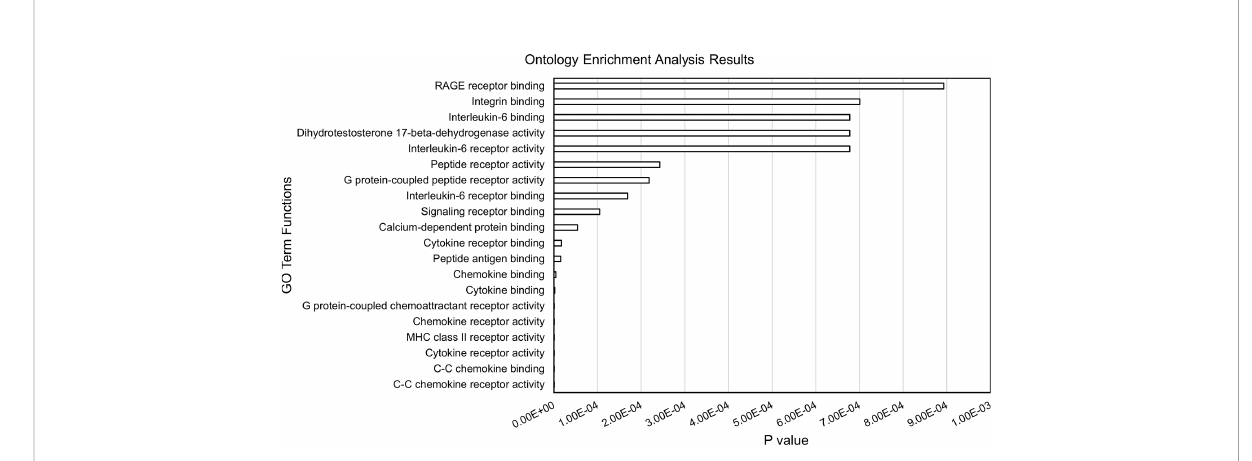
FIGURE 3 Results from ontology enrichment analyses of genes within the TADs encompassing the JIA risk loci and expressed in human